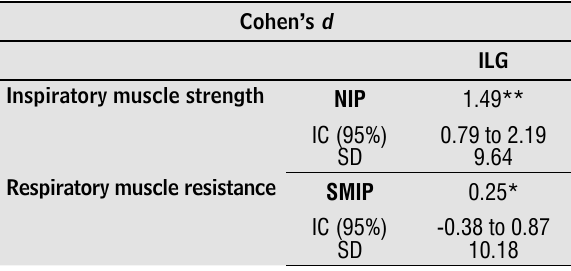
Table 3 – Size of the effect of the treatment for the treated groups as compared to the control group for the variables of NIP and